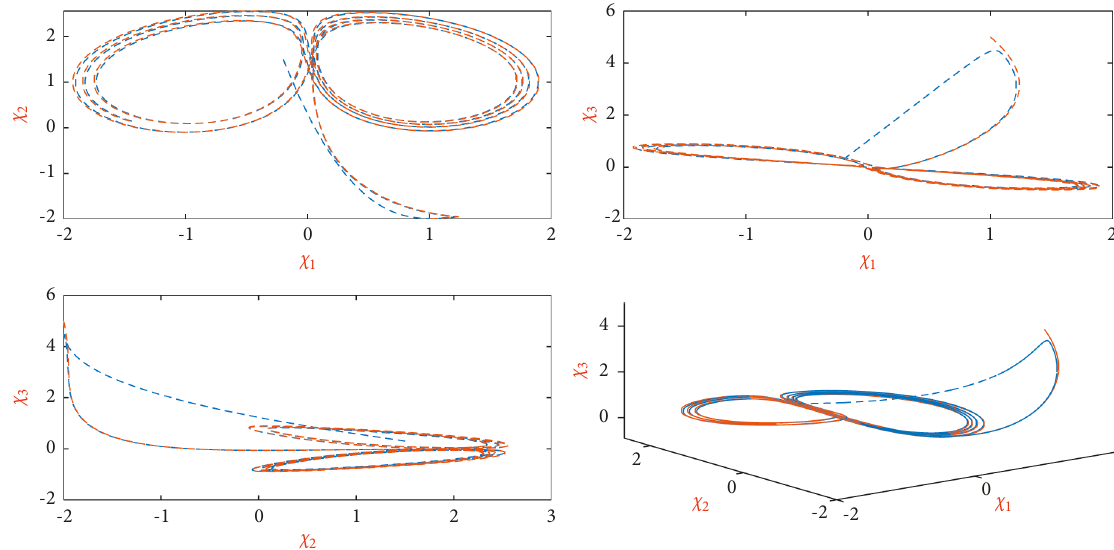
Figure 14: Scenario 6.2: a phase portrait.